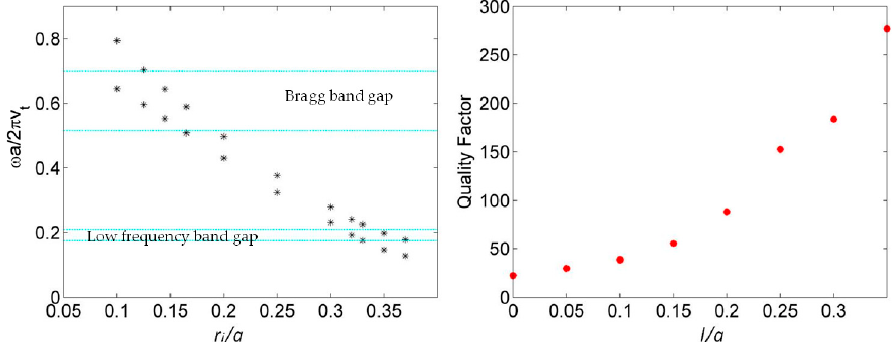
Figure 3. ( Left panel ): the frequency evolution of the WGM 1 and 2 as a function of the inner radius of the hollow pillar. The upper frequency range limited by two horizontal cyan lines is the Bragg band gap of background full PnCs ( h/a = 0.45, r/a = 0.4, l/a = 0) and the lower one is the low frequency band gap. ( Right panel ): The quality factor of the WGM 1 grows when increasing the confinement height l/a , r i /a = 0.145.